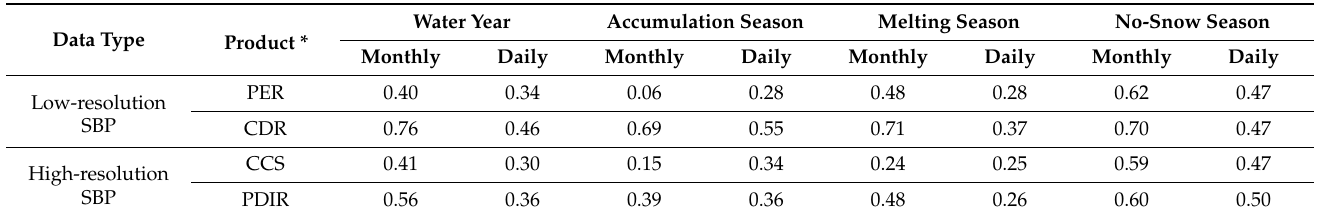
Table 4. The summary of the monthly and daily Pearson-R values of PVEs (January 2003–May 2015).